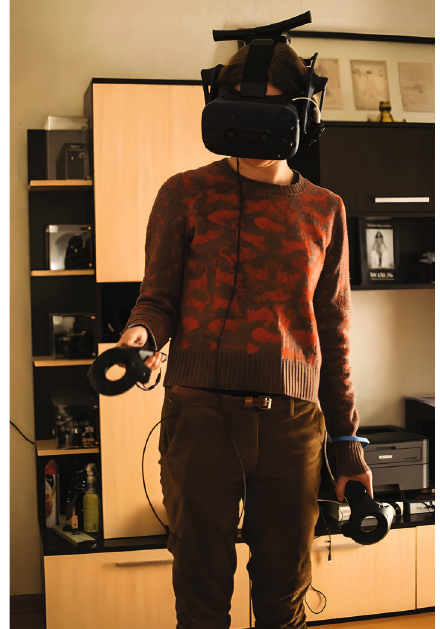
Figure 1: VR system with controllers and a